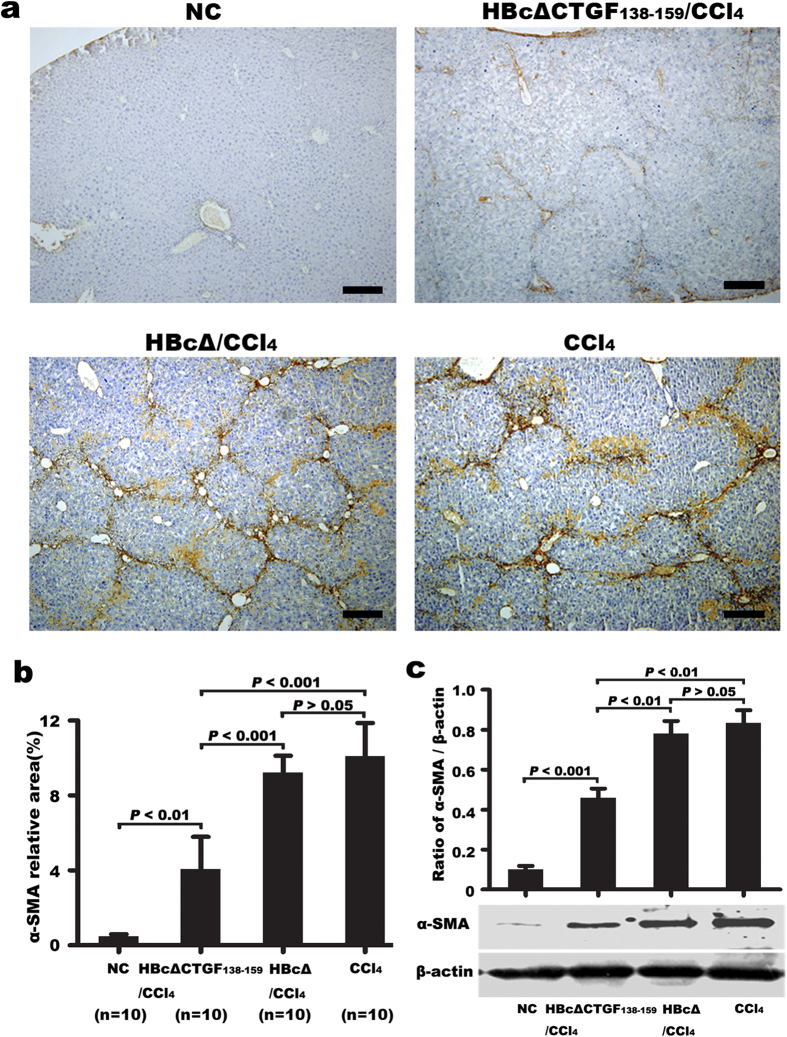
HBcΔCTGF138–159 vaccination suppressed HSC activation in the CCl4-induced fibrotic mouse livers.Immunohistochemical staining of α-SMA (a) followed by computer-assisted morphometric semi-quantitative analysis (b) and Western blotting (c) showed that vaccination with HBcΔCTGF138–159 suppressed the activation of HSCs in the fibrotic livers. Scale bars = 200 μm. Error bars indicate SEM. HSC, hepatic stellate cell; CCl4, carbon tetrachloride; α-SMA, α-smooth muscle actin.